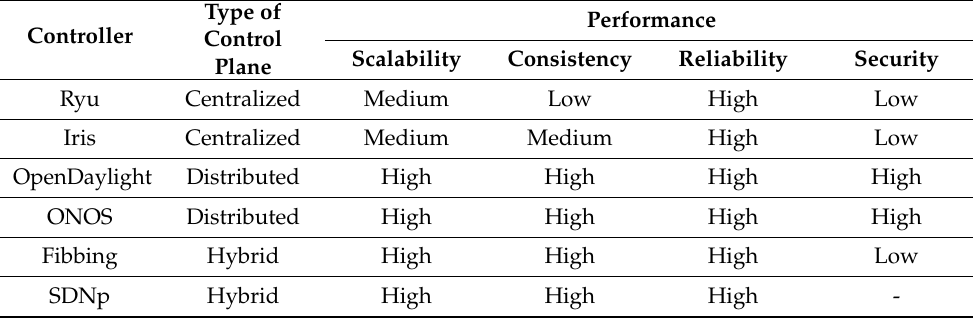
Table 4. Performance of the controllers